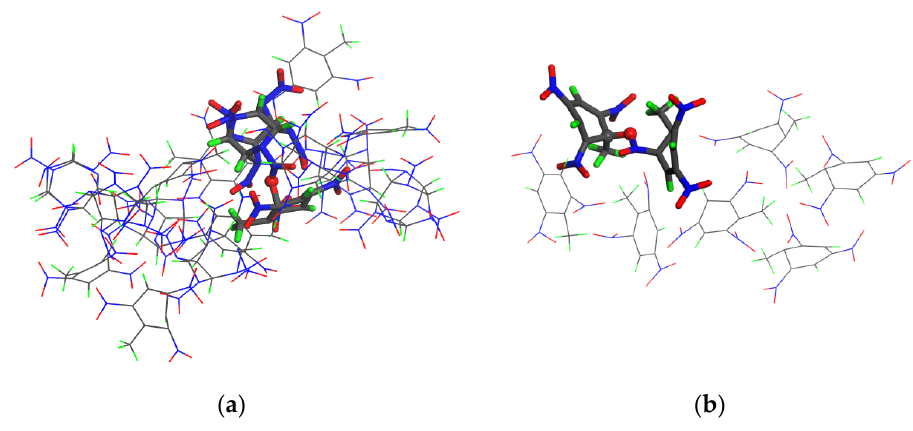
Figure 6. Molecular structure snapshots of the ( a ) CL-20/TNT (3 km/s 0.7 ps) and ( b ) TNT crystals (3 km/s 0.9 ps). C, H, O, and N atoms are colored gray, green, red, and blue, respectively. According to the above species analysis, NO 2 was the main initial decomposition product of the CL-20/TNT cocrystal and CL-20 crystal. Snapshots of the beginning of the appearance of NO 2 molecules in the CL-20/TNT cocrystal and CL-20 crystal are shown in Figure 7. From Figure 7a, formation of NO 2 in the cocrystal was mainly caused by direct cleavage of N–N bonds by CL-20 or TNT molecules, and most of the NO 2 molecules came from the decomposition of CL-20 molecules. In Figure 7b, the N atom originally connected to NO 2 was bonded to the O atom, and the N-NO 2 bond was broken at the same time. Therefore, it can be concluded that NO 2 in the CL-20 crystal was formed by a tt ack of the O atom on the N atom, and this resulted in the fracture of the N–NO 2 bond.